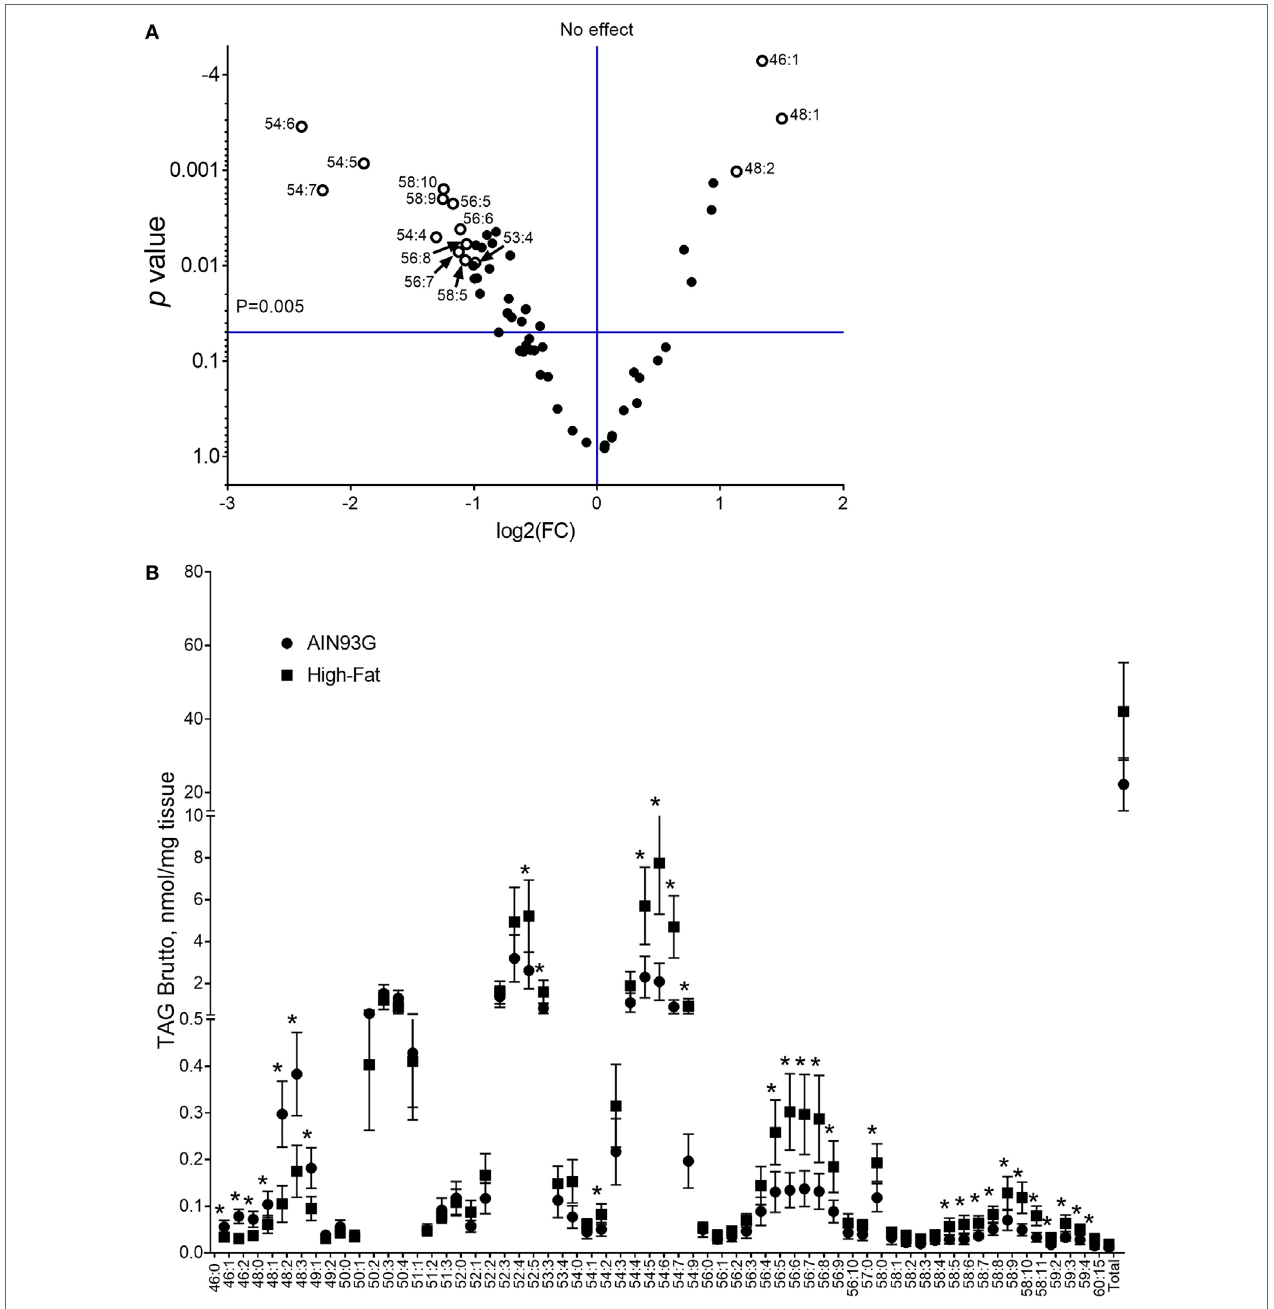
FigUre 6 | Volcano plot with a twofold difference (a) and concentrations of triacylglycerols [(TAG); (b) ] in the primary tumor of Lewis lung carcinoma from mice fed the AIN93G diet or the high-fat diet (HFD). Values are mean ± SD ( n = 5 for the AIN93G group and n = 6 for the HFD group). * p ≤ 0.05 for each